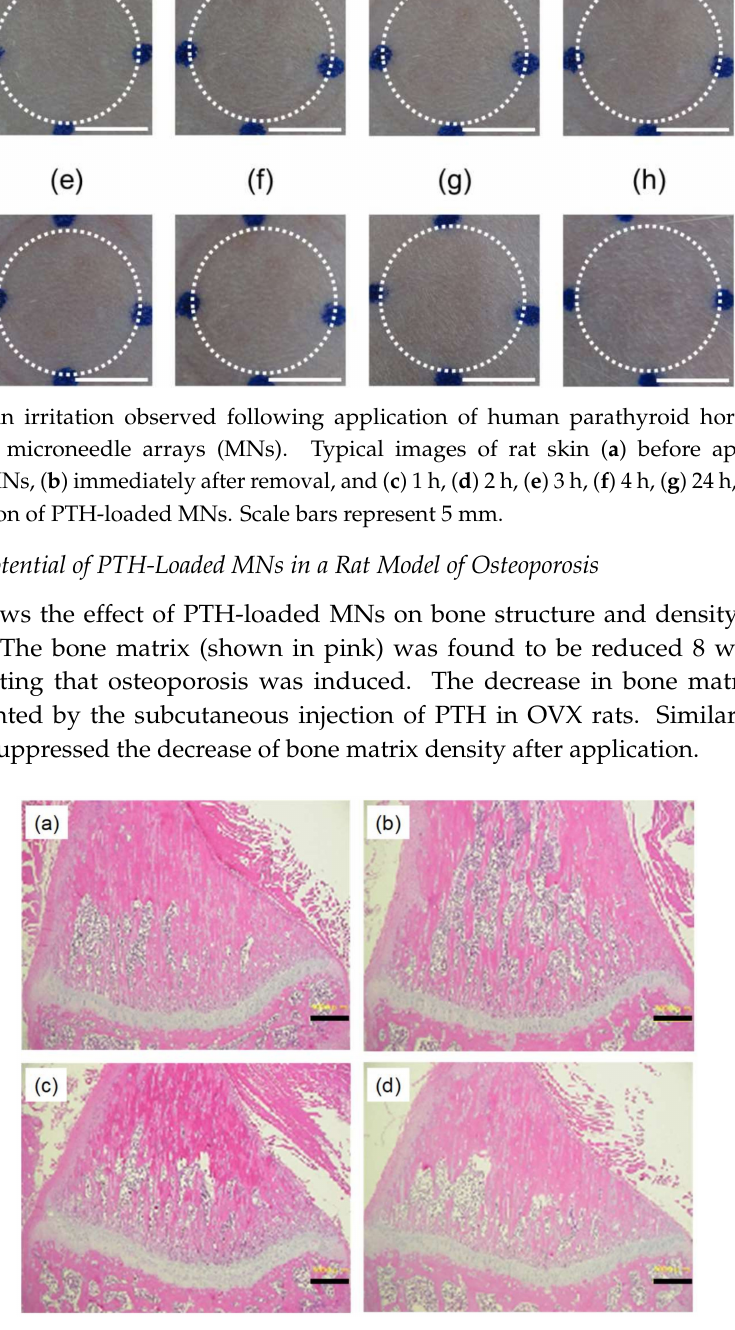
Figure 8. Histological micrographs of bone tissue from rat tibias following application of human parathyroid hormone (1-34) (PTH)-loaded microneedle arrays (MNs) in rats with ovariectomy (OVX)-induced osteoporosis. ( a ) Naïve, ( b ) OVX, ( c ) subcutaneous administration of PTH, and ( d ) PTH-loaded MNs. Scale bars represent 500 µ